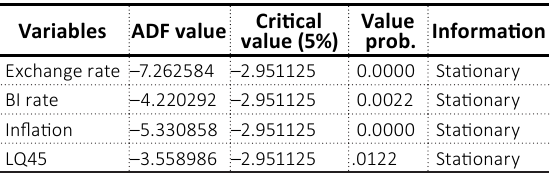
Table 1. Test of stationairity